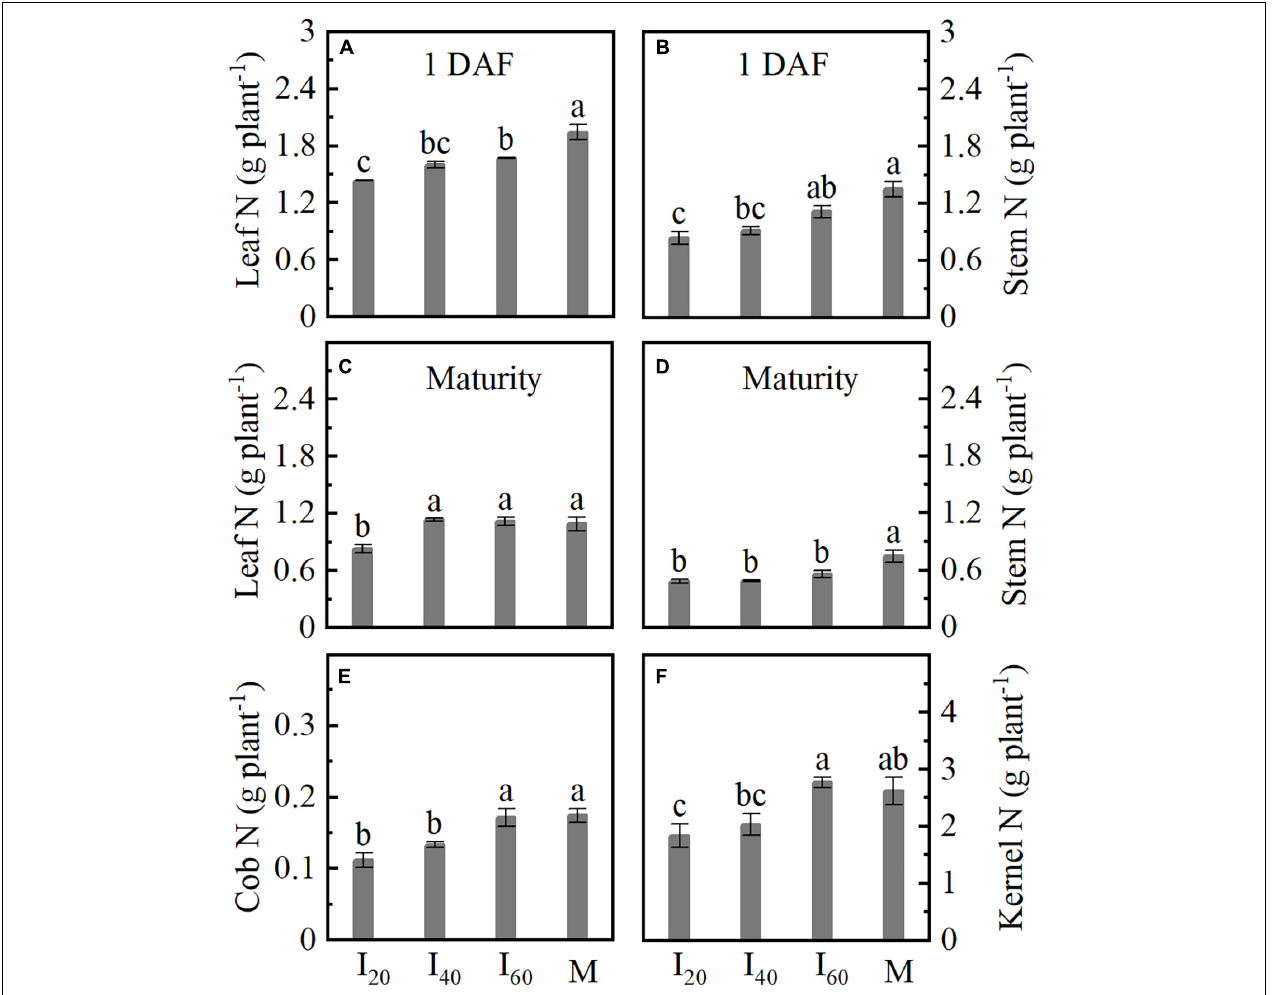
FIGURE 4 | Nitrogen (N) accumulation in respective organs in Study 1 (2020). I 20 , I 40 , and I 60 represent the intercropping maize planted in the narrow–wide row spacing patterns, narrow and wide row spacing of 20 + 200, 40 + 180, and 60 + 160 cm, respectively. M: monoculture maize with a row spacing of 70 cm. (A) Leaf N uptake at 1 day after flowering. (B) Stem N uptake at 1 day after flowering. (C–F) The leaf, stem, cob, and kernel uptake at maturity. Data with the different letters are significantly different ( p <